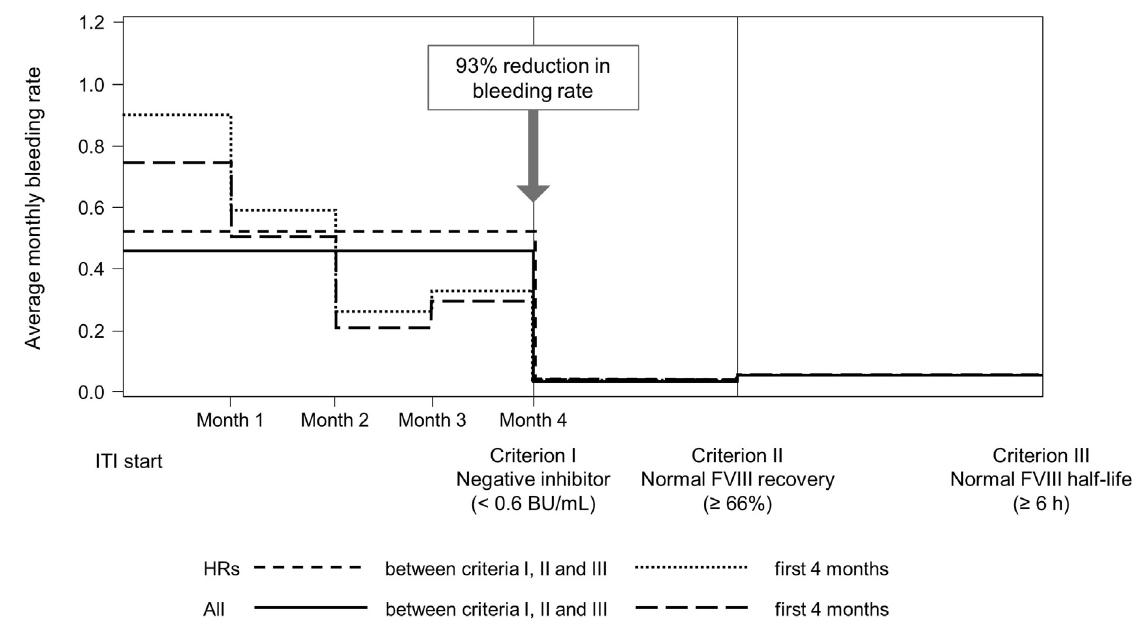
Fig. 4 Bleeding rates before immune tolerance induction (ITI) and after achievement of criteria I, II, and III. FVIII, factor VIII.